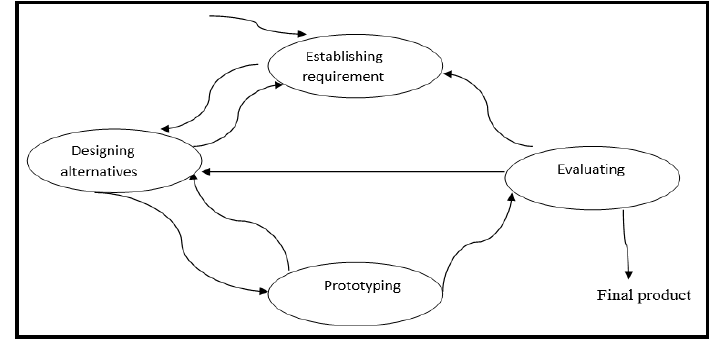
Fig. 2. Interaction Design Model